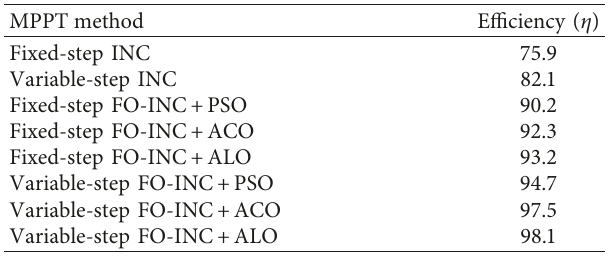
Figure 13: Optimization of variable-step FO-INC I-V and P-V curves. Table 5: MPPT algorithms